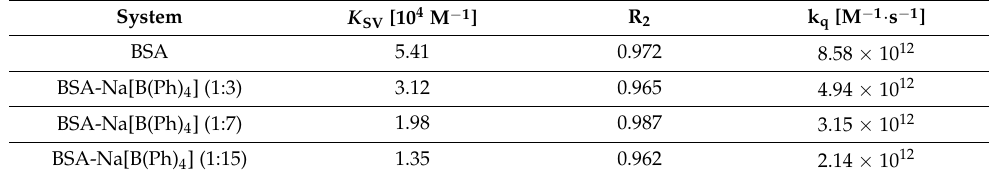
Table 2. Stern–Volmer quenching constants, linear correlation coefficients (R 2 ) and bimolecular quenching rate constants (k q ) recovered for the steady-state fluorescence quenching of pure BSA and its mixtures with Na[B(Ph) 4 ] (1:3; 1:7; and 1:15) by SDS in the 10 mM Caco buffer of pH 7.0 at 298 K.